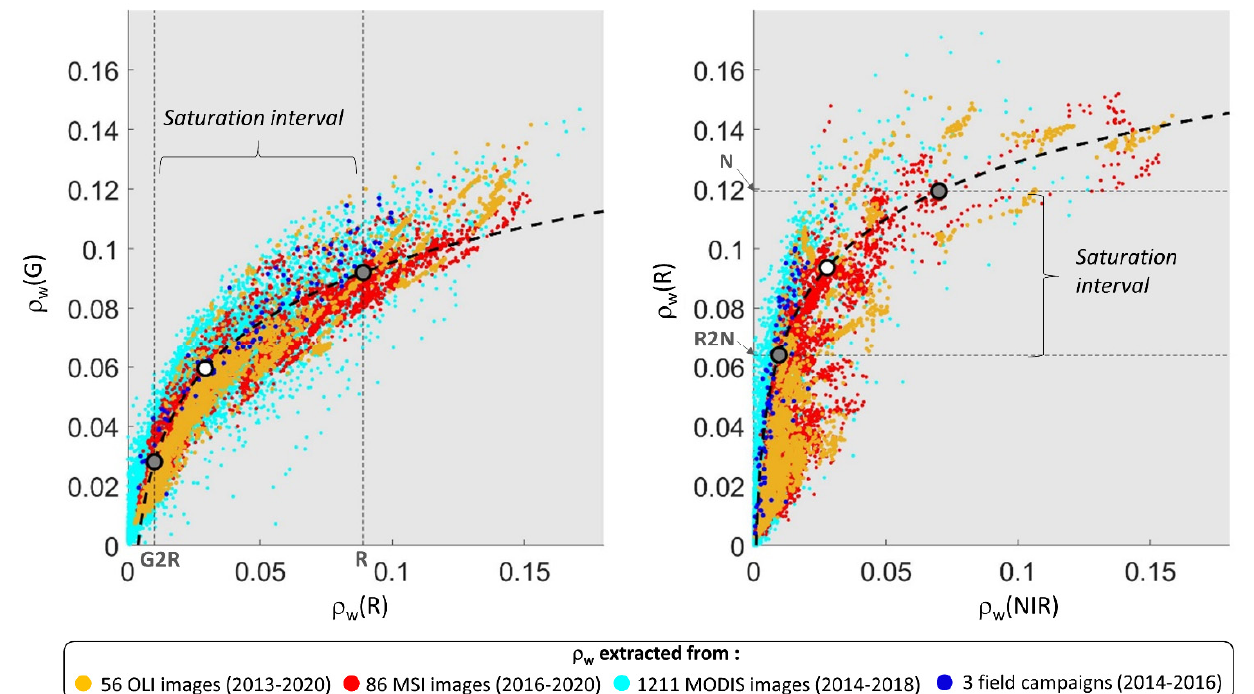
Figure 4. Switching algorithm saturation points (white circles) and saturation intervals radiometric bounds (G2R, R, N, N2R) (grey points) computed from band-to-band relationships (values for the three sensors are available in Table 3). Satellite-derived ρ w data were extracted from a transect going from the SORA station to the offshore limit of the river plume for each satellite image (Figure A5, Appendix A). Before computation, the band-to-band relationships were modeled using a logarithmic curve (dashed line) (See Appendix A for more details).